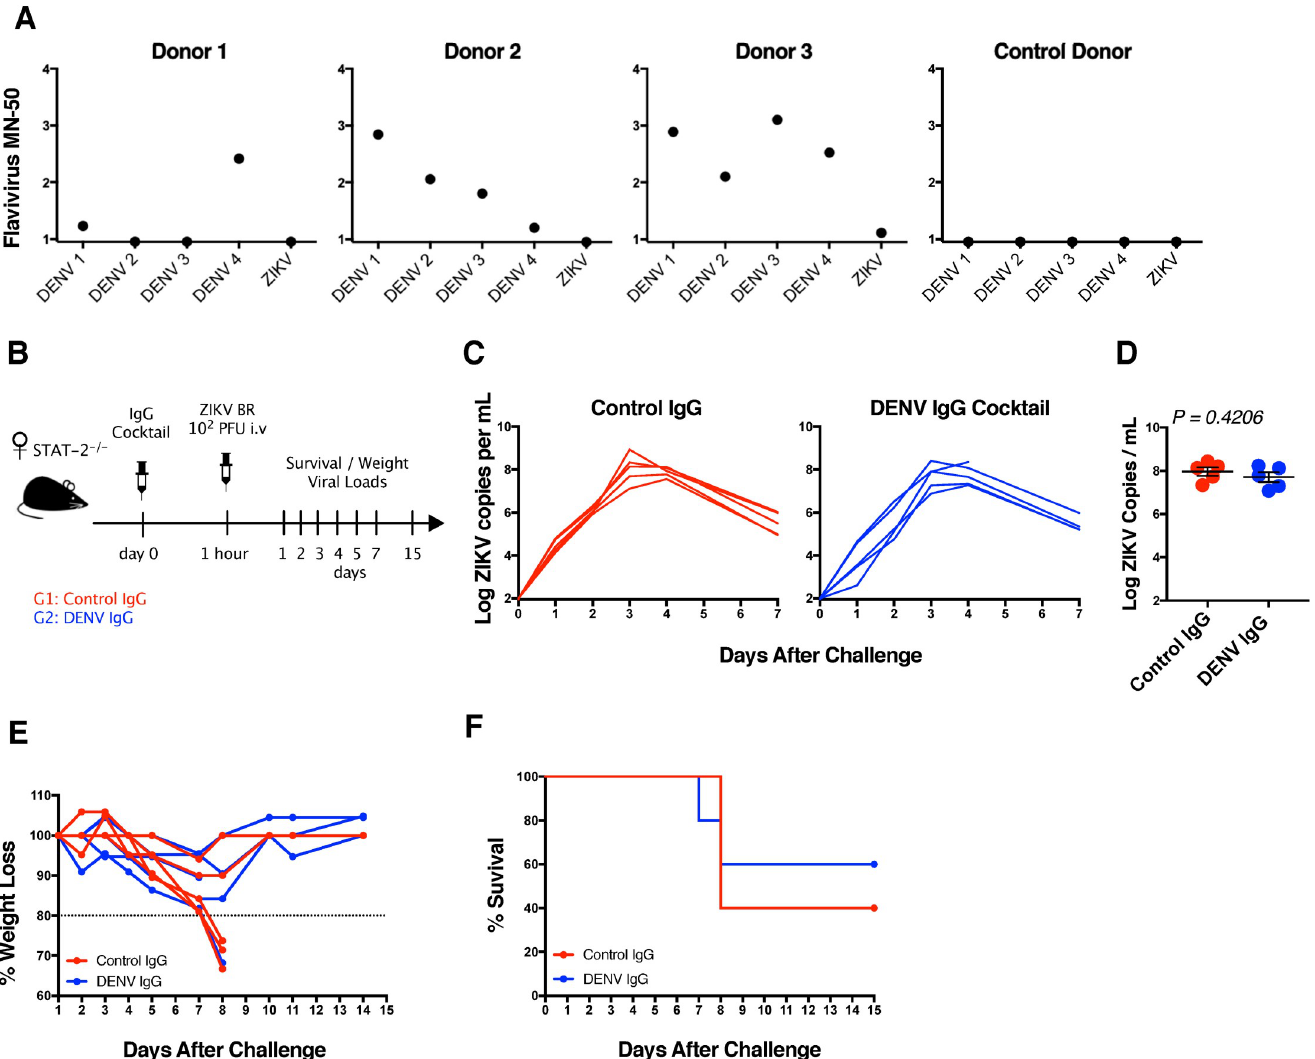
Fig 5. Passive transfer of anti-DENV IgG in STAT-2 -/- mice. Anti-DENV IgG (200 μ g) isolated from 3 donors were pooled and passively transferred into STAT2 -/- mice. (A) MN50 for previous flavivirus infection in 3 DENV infected donors and 1 control donor. One-hour post IgG transfer, mice were challenged i.v. with 10 2 PFU ZIKV-BR. (B) Schematic design of the experiment. (C) ZIKV mRNA viral load in control-IgG and DENV-IgG recipients. (D) Peak viral load comparison in control-IgG vs DENV-IgG recipients. (E) Percentage weight loss in mice post ZIKV challenge. (F) Percentage of mice survival post ZIKV challenge. Data is representative of one experiment with n = 5 animals per group. Each line represents an individual mouse. P values were calculated using a Mann-Whitney U test . Mean ± SEM is shown.